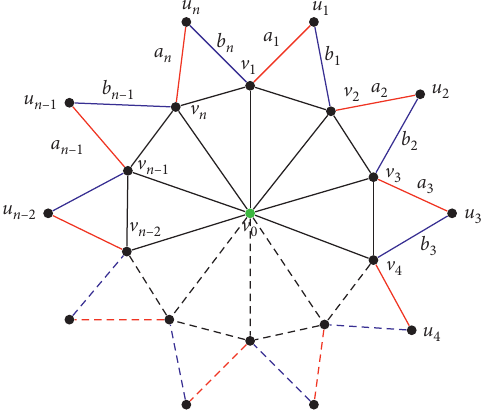
Figure 26: The graph SF